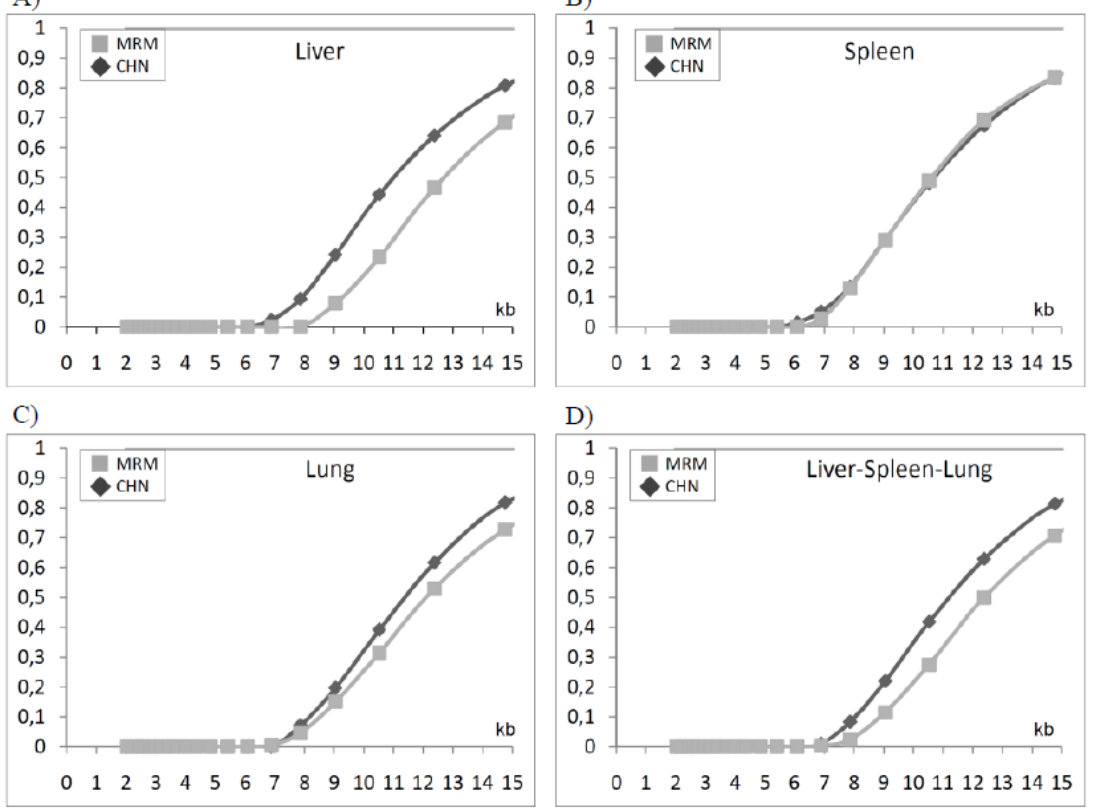
Figure 4. The size distribution of telomeres in the indicated tissues was calculated and expressed as a cumulative fraction versus size (see Experimental methods) the resulting distribution curves in liver (A) , lung (B) and spleen (C) from Chianina and Maremmana cattle breeds by using Telorun program. In (D) , distribution curves from liver, spleen and lung were analyzed